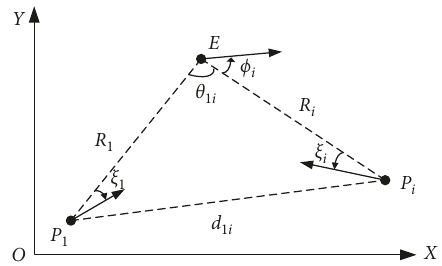
Figure 1: Relative motion between pursuers and